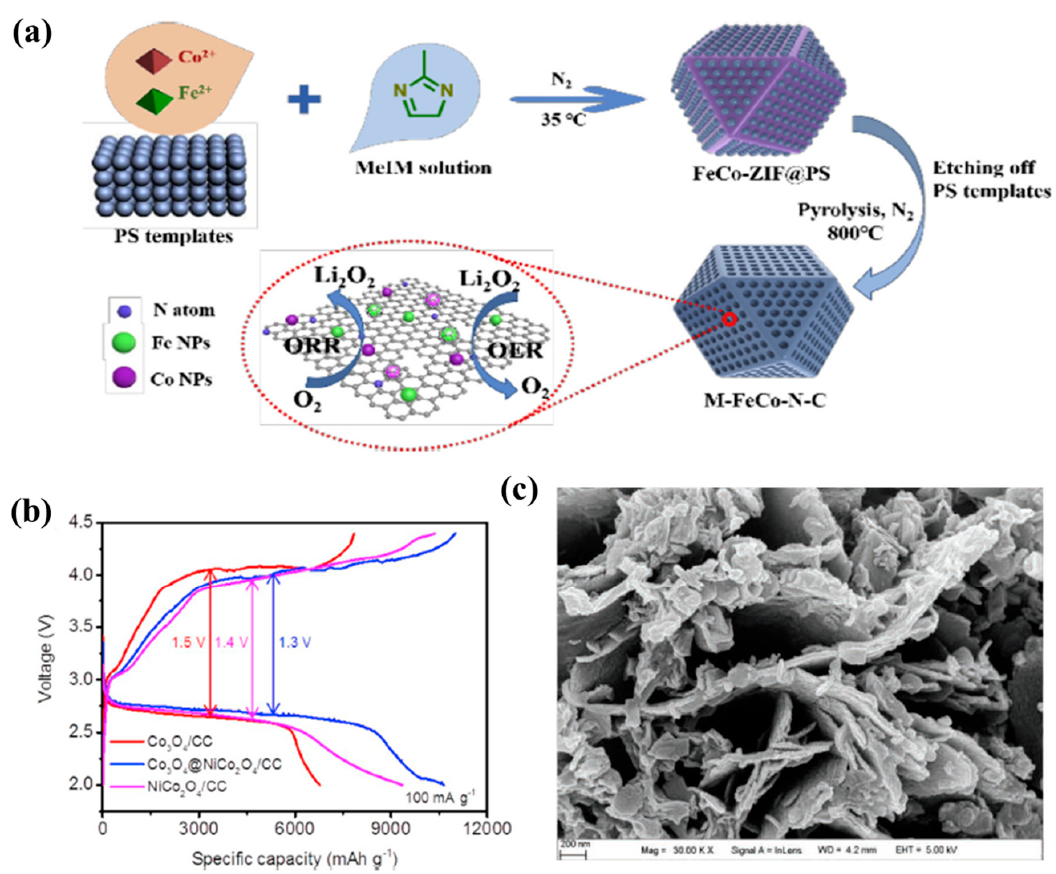
Figure 9. ( a ) The illustration of the synthetic process of M-FeCo-N-C-X catalysts [119]. ( b ) The first discharge–charge curves of Co 3 O 4 / CC, Co 3 O 4 @NiCo 2 O 4 / CC, and NiCo 2 O s / CC catalysts [120]. ( c ) The FESEM image of 1MIL / 40ZIF-1000 [123].